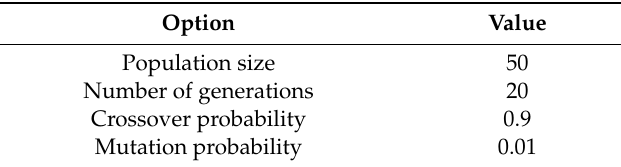
Table 3. Initial parameter settings.